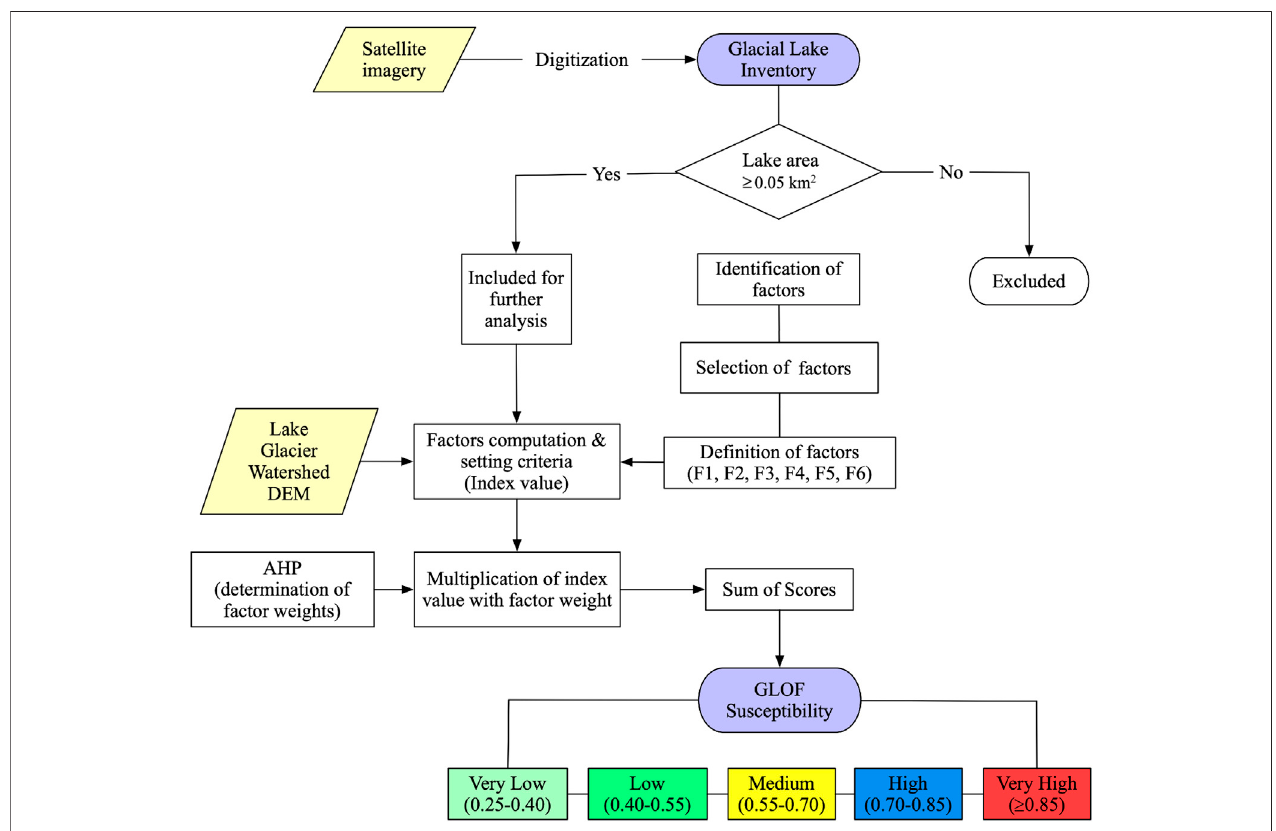
FIGURE 2 | Flowchart for GLOF susceptibility evaluation. AHP represents the analytical hierarchy process. Refer to Figure 4 for the de fi nition of factors.